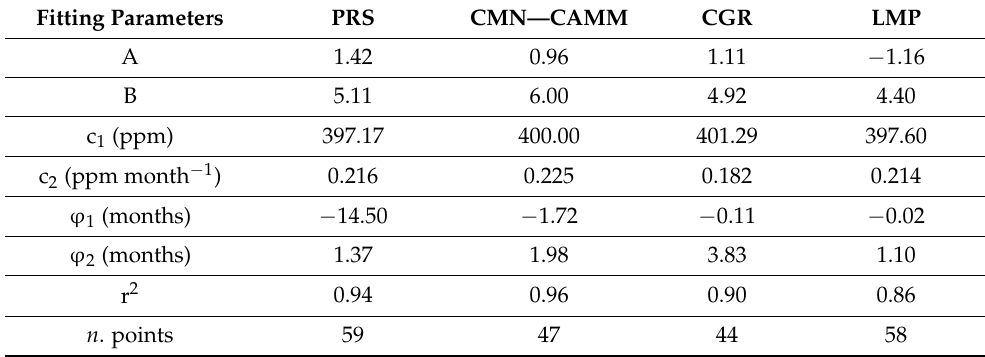
Table 5. Parameter of the fit (Equation (1)) to the background-selected dataset (monthly mean). Fitting Parameters PRS